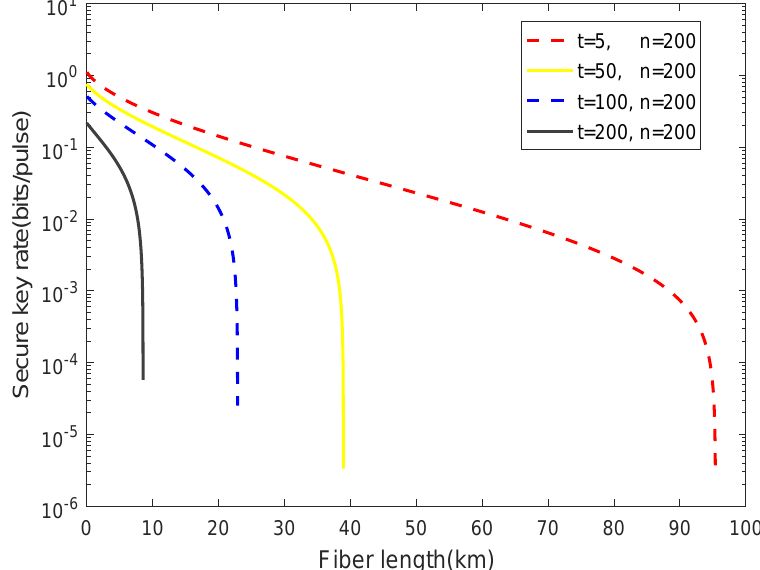
Figure 5. The secret rates of different numbers of legitimate participants for n = 200. The parameters are given by V A = 6, γ = 0.2 dB/km, ε = 0.001, κ = 0.98, η = 0.6, and v el =